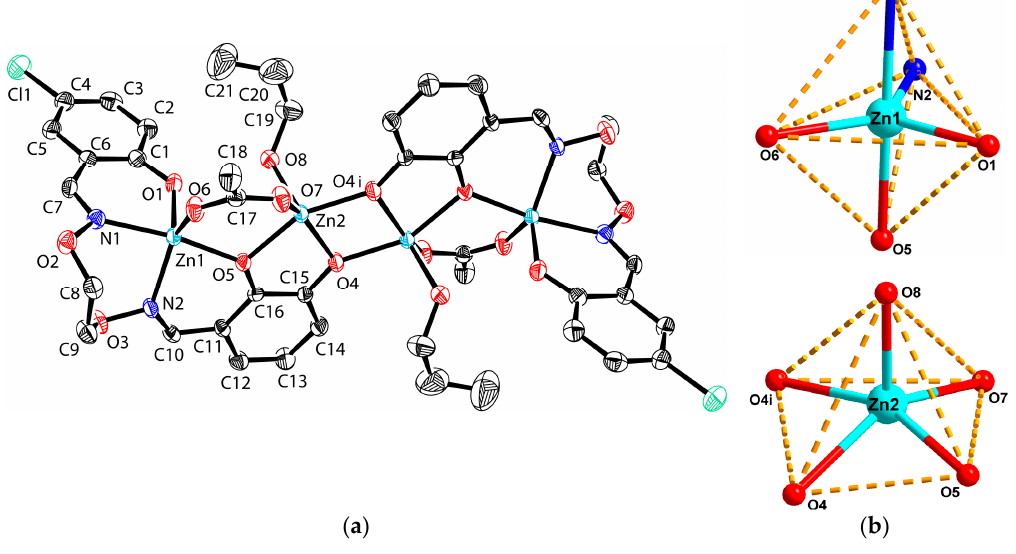
Figure 3. ( a ) Molecular structure and atom numberings of complex 2 with 30% probability displacement ellipsoids (hydrogen atoms are omitted for clarity). ( b ) Coordination polyhedra for Zn1 and Zn2 ions of complex 2 .